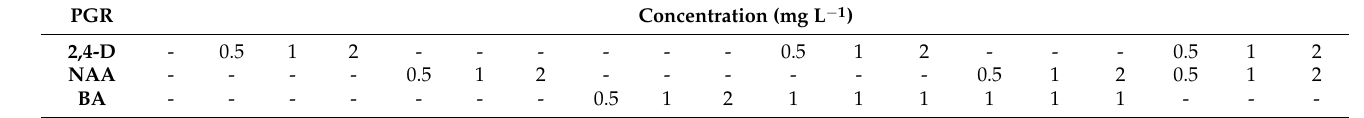
Table 1. Concentrations of PGRs supplemented to MS medium to induce callus from L. schweinfurthii